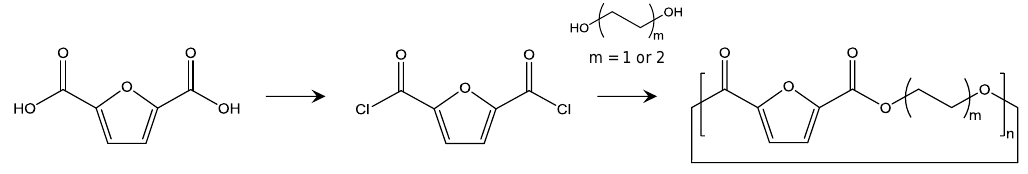
Figure 9. Synthetic scheme of cyclic oligomers for PEF and PBF [98,99].